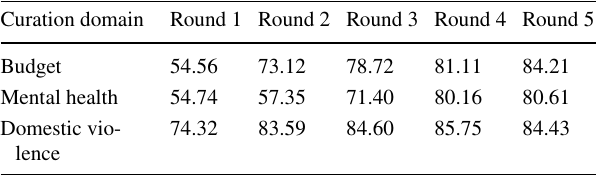
Table 2 Precision of the approach in adapting rules using summariza- tion approach K = 20 Curation